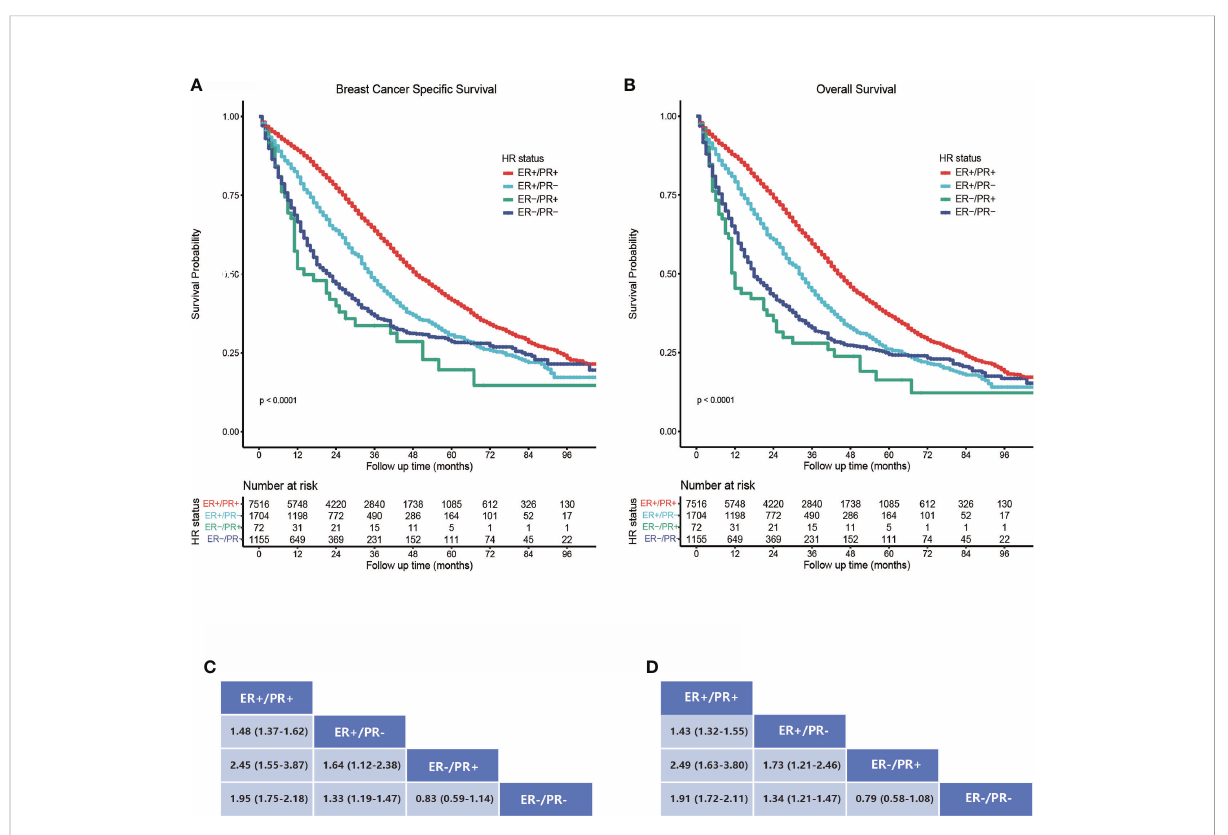
FIGURE 2 Survival analysis of bone metastatic breast cancer patients strati fi ed by hormone receptor status. (A) Kaplan – Meier survival curves show a breast cancer-speci fi c survival rate difference. (B) Kaplan – Meier survival curves show an overall survival rate difference. (C, D) Data are presented as hazard ratios (95% CIs) between HR status subgroups regarding BCSS and OS. A hazard ratio exceeding 1 favors the column- labeled HR status